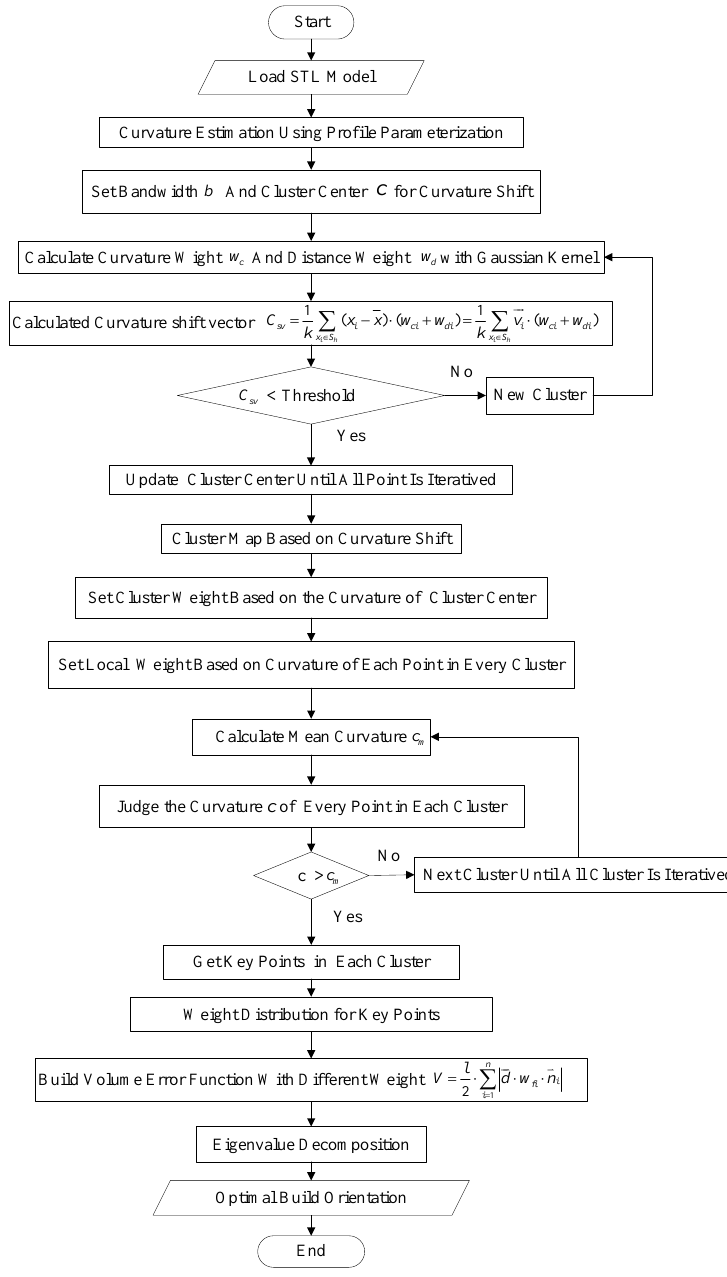
Figure 7. Methodology for the process of optimizing the build